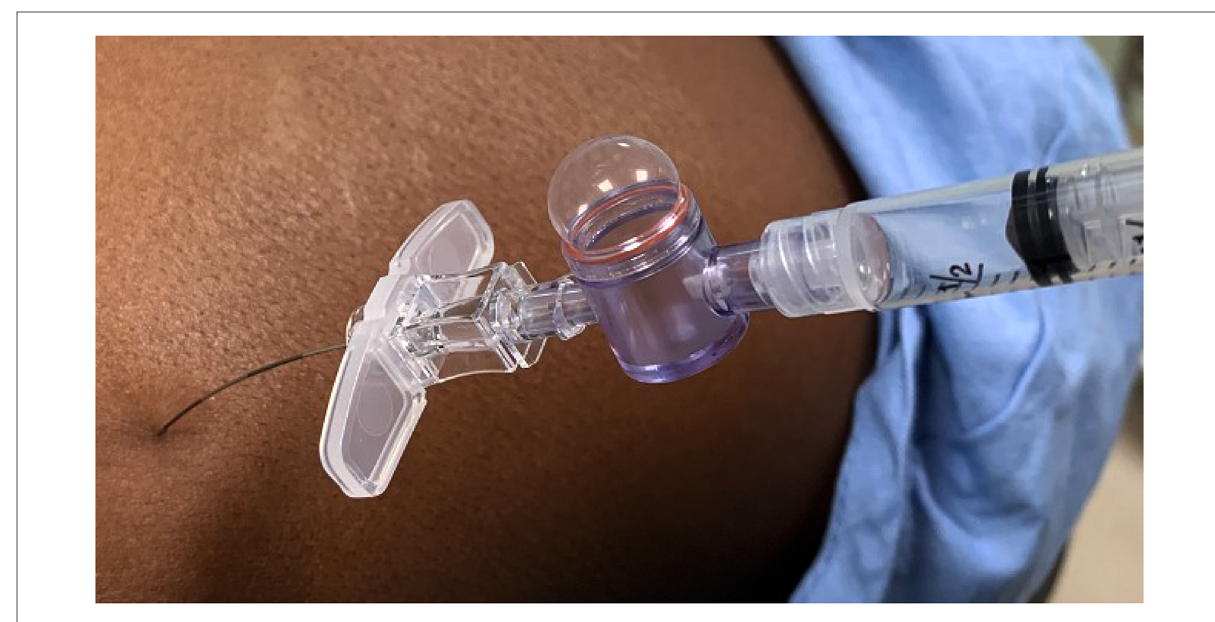
FIGURE 1 Epidrum. The Epidrum connected to a 25 G Tuohy needle is still in fl ated after 30 s. The result is negative.